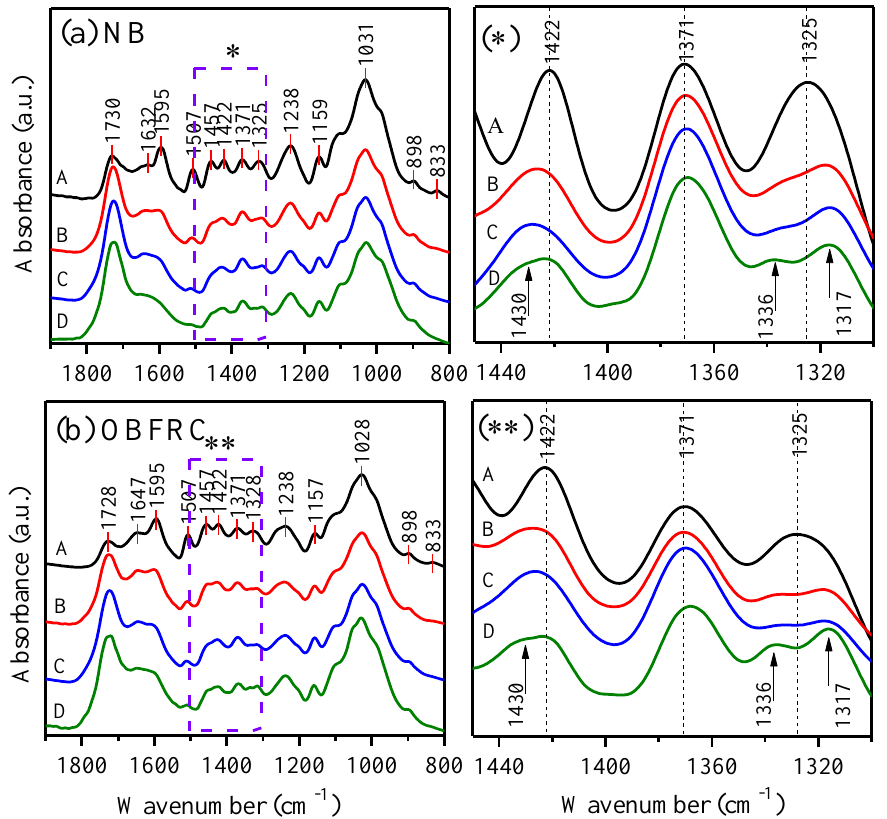
Figure 6. FTIR spectra of ( a ) NB and ( b ) OBFRC for differing periods of UV irradiation: A, 0 h; B, 50 h; C, 150 h; D, 200 h. Note: ( * ) and ( ** ) are the details in the dotted box in ( a , b ), respectively. Table 2. Summary of characteristic peaks in the 1800 cm − 1 – 800 cm − 1 region of FTIR-ATR spectra for NB and OBFRC [2,28,38,39].